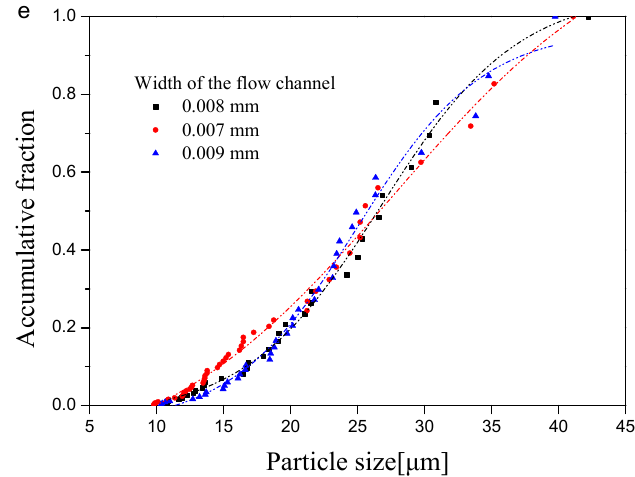
Figure 10. Comparison of ( a ) width of the fluid channel; ( b ) atomization of the liquid phase; ( c ) spray angle; ( d ) velocity and ( e ) particle size distribution between cases 0, 7, and 8.